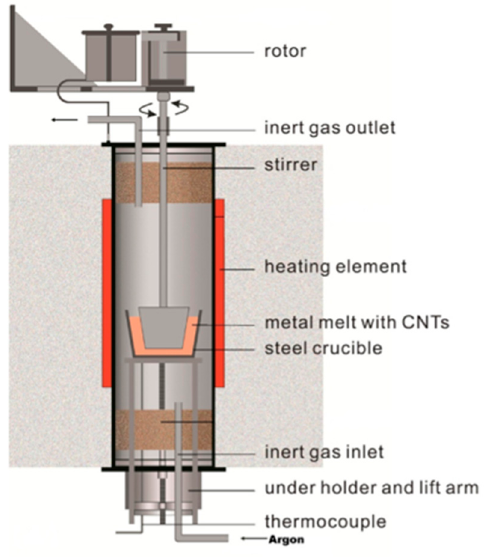
Figure 1. Schematic drawing of the melt stirring furnace used in this study.